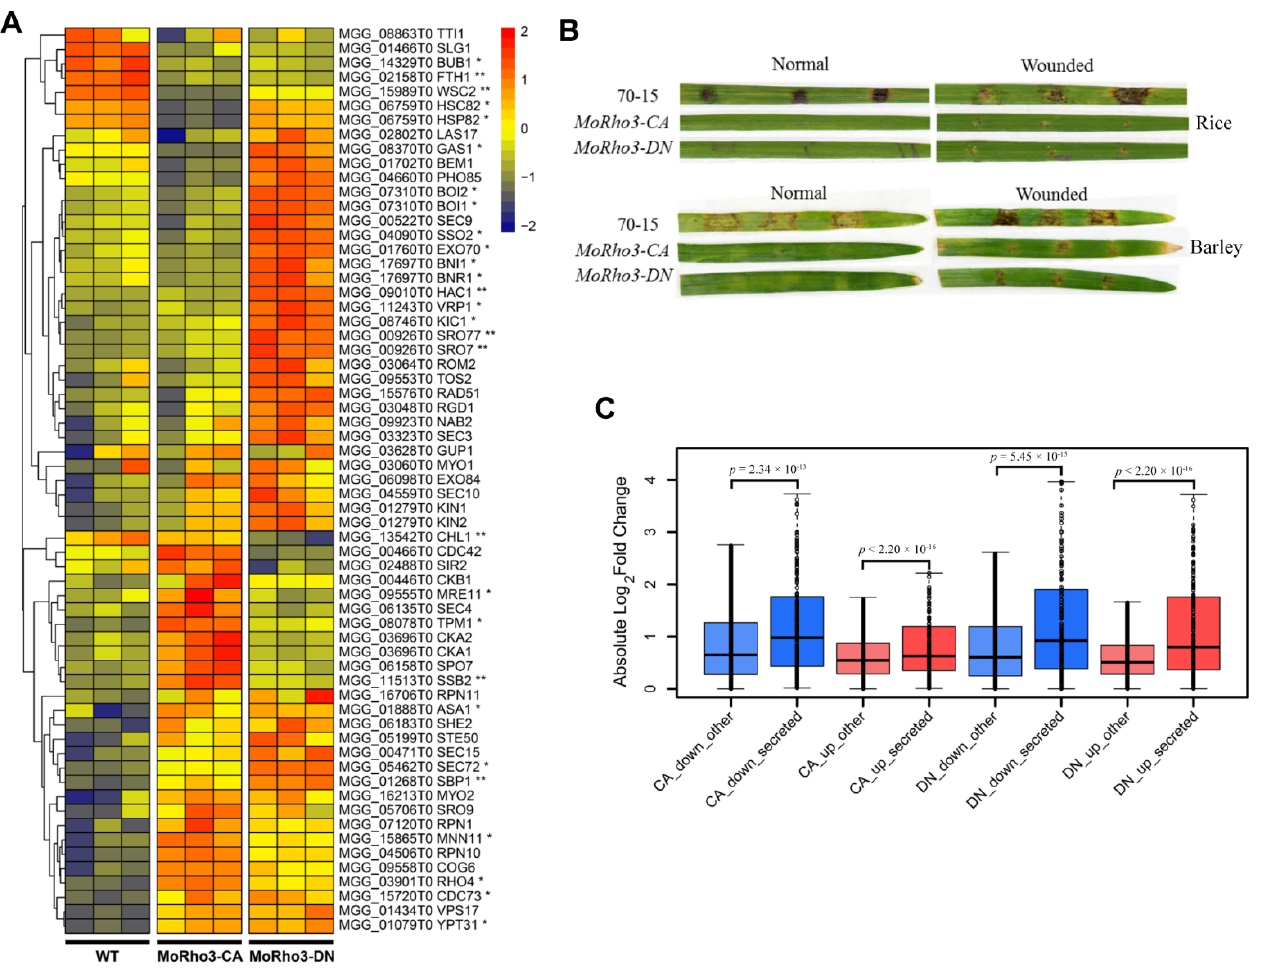
Figure 5. CA mutation regulates melanin biosynthesis. ( A ) Colony morphology of wild-type 70-15, Figure 6. CA and DN mutations affect the expression of genes involved in the protein secretory MoRho3-CA , and MoRho3-DN strains growing on CM medium. ( B ) The growth rate of MoRho3-CA , pathway. ( A ) Expression analysis of orthologous genes of Saccharomyces cerevisiae Rho3 interaction MoRho3-DN mutant. Error bar represents standard deviation from three replications and * represent proteins in M. oryzae . * stands for fold change >1.5. ** stands for fold change >2. ( B ) Pathogenicity significant difference ( p < 0.05). ( C ) GO enrichment comparison of up- or down-regulated DEGs assays of rice and barley leaves inoculation with MoRho3-CA/DN mutants. ( C ) Comparison of secreted between MoRho3-CA and MoRho3-DN mutant. ( D ) Expression comparison of three melanin biosyn- (blue and red) and non-secreted (light blue and light red) protein expression in CA and DN thesis genes MGG_05059, MGG_07216, and MGG_02252 in MoRho3-CA , and MoRho3-DN mutants.